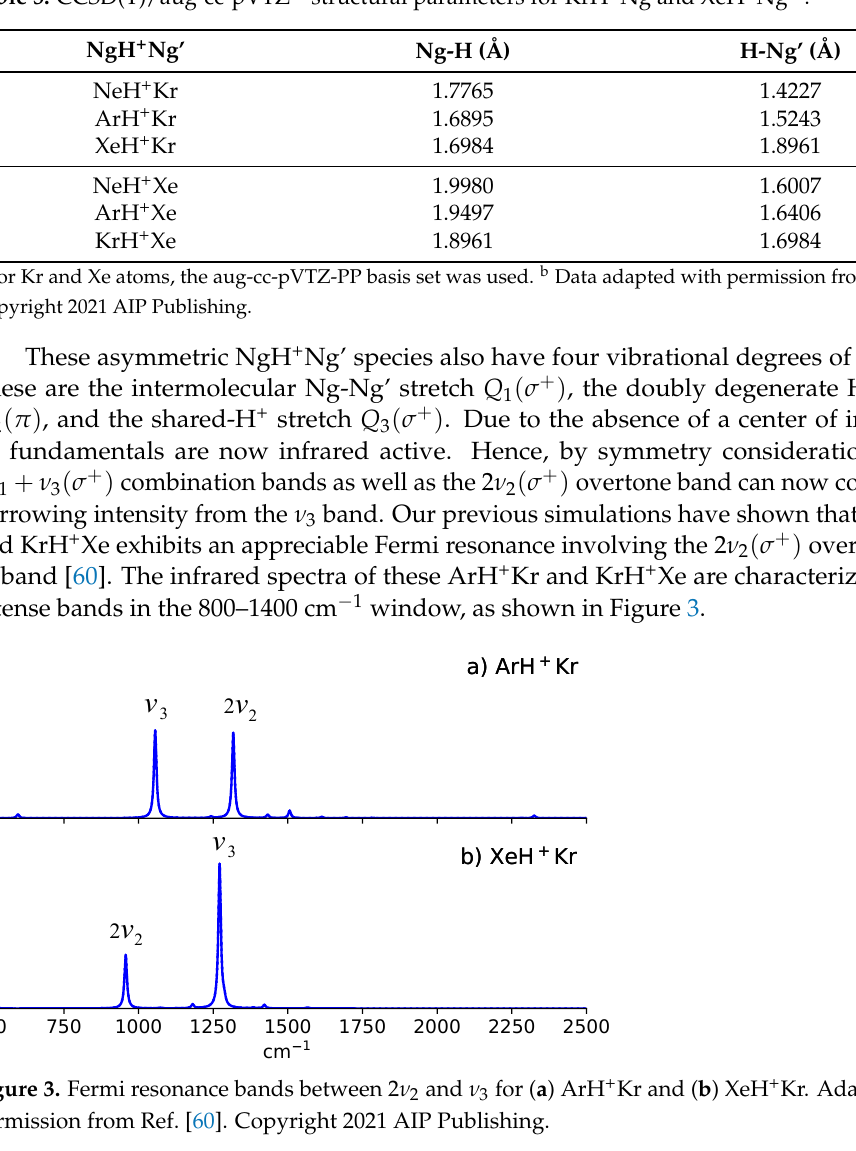
Table 5. CCSD(T)/aug-cc-pVTZ a structural parameters for KrH + Ng and XeH + Ng b .